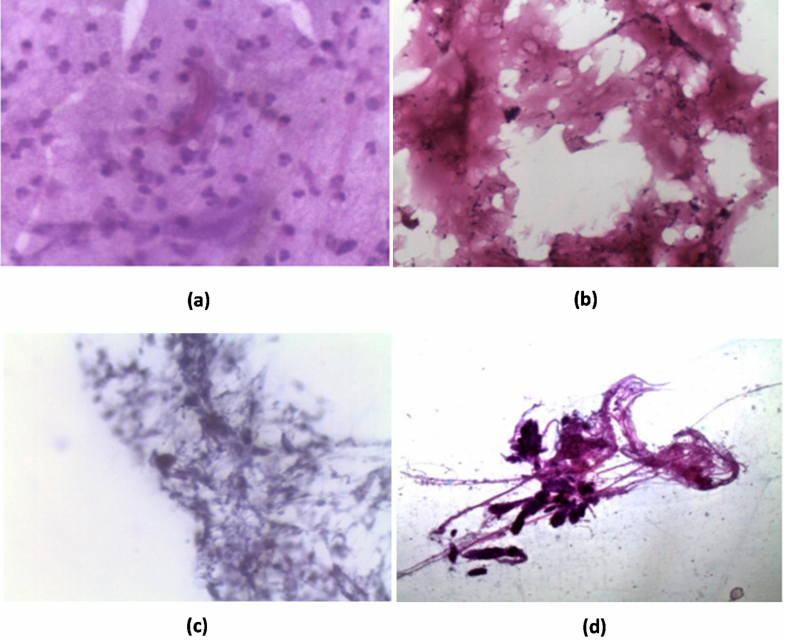
Figure 6. Images ( a , b ) correspond to positive control. ( a ) Large amount of basophilic material, slightly translucent, with a large cellular component, composed mainly of polymorphonuclear leukocytes, and predominantly heterophiles. In isolation, traces of an eosinophilic, amorphous, fibrillar, and acellular material can be found. ( b ) A fibrillar material, amorphous, eosinophilic, acellular, and in large quantities. ( c ) Negative control shows material that is slightly basophil, which has very fine fibers, forming networks, with few cells between their fibers. The material can be compatible with synovial fluid of the joint. ( d ) Synovial fluid extracted at a sampling point of 12 months shows fibrillar material, eosinophil, cell inflammation, and mostly composed of heterophilic polymorphonuclear cells and